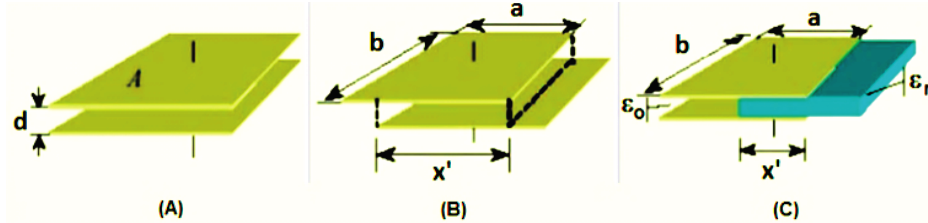
Figure 1. Illustration of a Capacitive Sensor of Parallel Plates, where ( a ) indicates a possible variation in the distance between the plates; ( b ) indicates a possible variation of the common surface; and ( c ) the alteration of the dielectric